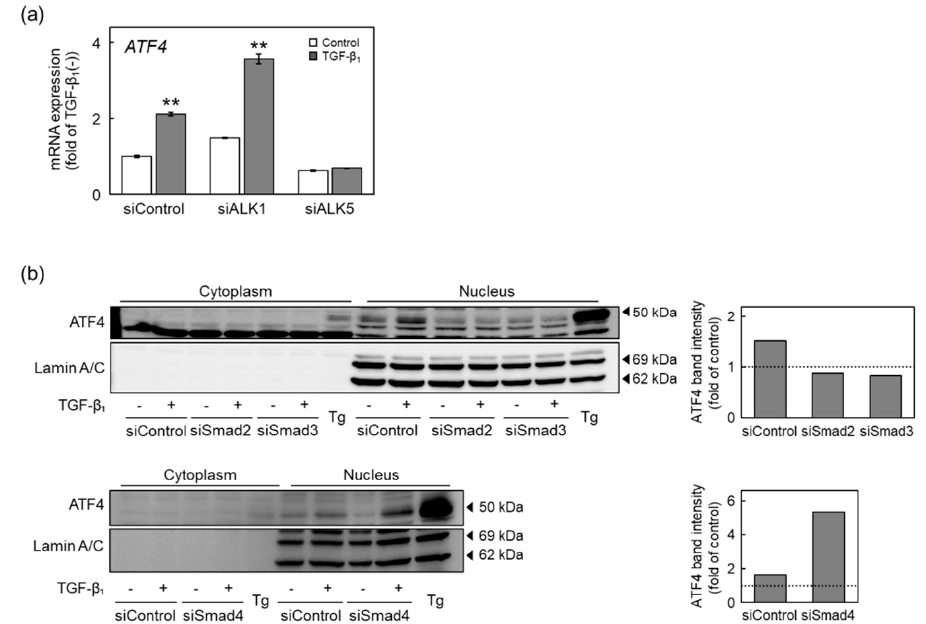
Figure 7. Involvement of the Smad pathway in the upregulation of ATF4 expression by TGF- β 1 in vascular endothelial cells. ( a ) Expression of ATF4 mRNA in ALK1- or ALK5-suppressed vascular endothelial cells treated with TGF- β 1 . Subconfluent cultures of vascular endothelial cells were transfected with ALK1 or ALK5 siRNA for 4 h and then treated with TGF- β 1 (10 ng/mL) for 12 h. Values are means ± S.E. of three independent samples. The data were analyzed using one-way ANOVA, followed by Tukey–Kramer’s test. ** Significantly different from the corresponding control, p < 0.01. ( b ) Level of ATF4 protein in Smad2-, Smad3-, or Smad4-suppressed vascular endothelial cells treated with TGF- β 1 . Subconfluent cultures of vascular endothelial cells were transfected with either Smad2, Smad3, or Smad4 siRNA for 4 h and then treated with TGF- β 1 (10 ng/mL) for 12 h or with thapsigargin (Tg; 0.1 µ M) as a positive control for 9 h to express ATF4. Lamin A/C are used as a nuclear loading control. The arrowheads indicate the corresponding protein. Quantification of band intensities of ATF4 in nucleus (right panels). The data are representative of two independent